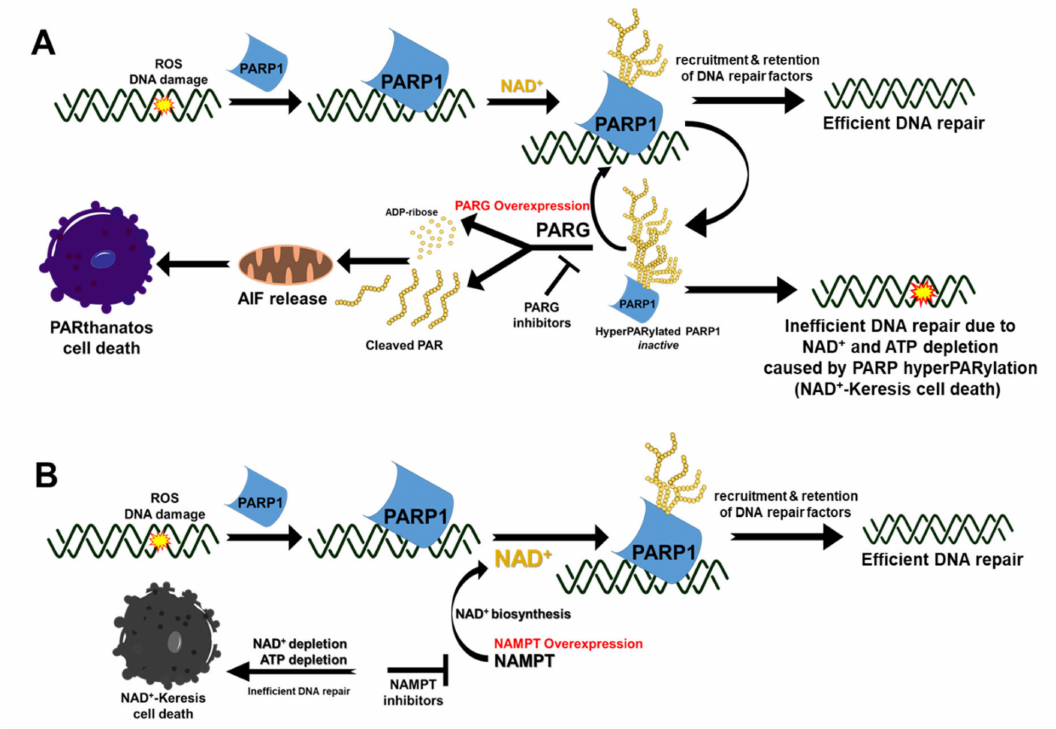
Figure 2. Pharmacological modulation of PAR ad NAD + in cancers for therapy. ( A ) Mechanism of PARthanatos mediated by the translocation of cleaved PAR from the nucleus to the cytosol and mitochondria to induce the release of AIF that translocates into the nucleus to initiate death in PARG-overexpressing cancers. Alternatively, breakdown and recycling of PAR can be prevented by inhibition of PARG to enhance NAD + depletion caused by PARP hyperactivation, ultimately starving the cell of ATP needed for various critical cellular processes (e.g., DNA repair). ( B ) In cancer cells that overexpress NAMPT, the use of NAMPT inhibitors interfere with generation of intracellular NAD + levels that compromise PARP activity, consequently resulting in impaired repair of DNA damage and NAD +